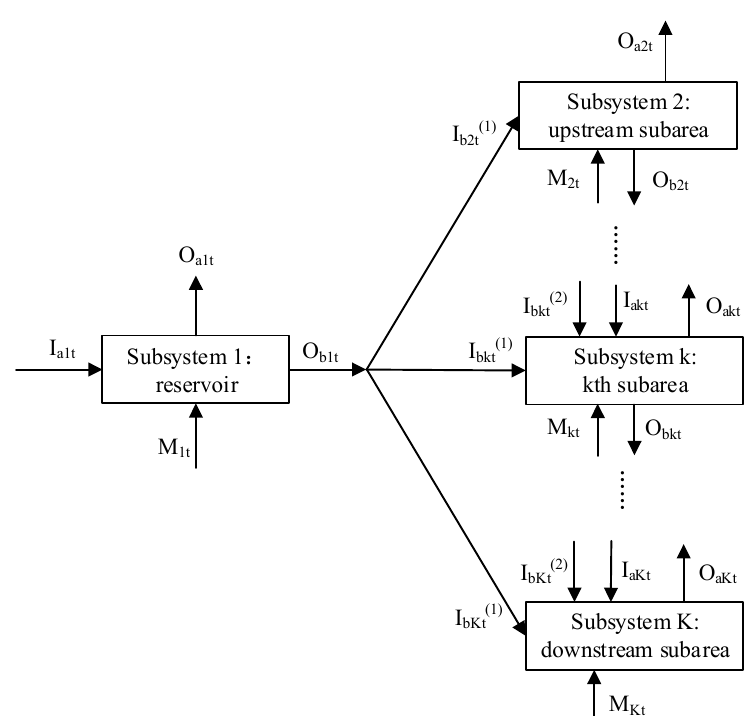
Figure A2. The mutual relationship of all subsystems of the water resources system. Table A2. The main parameters in large system model of water Table A1. System model parameters.